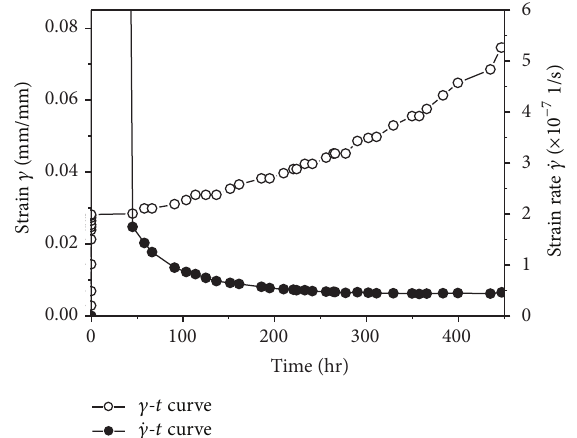
𝛾 - t curve - t curve 𝛾 ˙ Figure 11: Correlation between strain-time and strain rate under a temperature of 408K and a load of 7.35 N in the shear creep experiment. Figure 12: Correlation between the natural logarithm of the strain